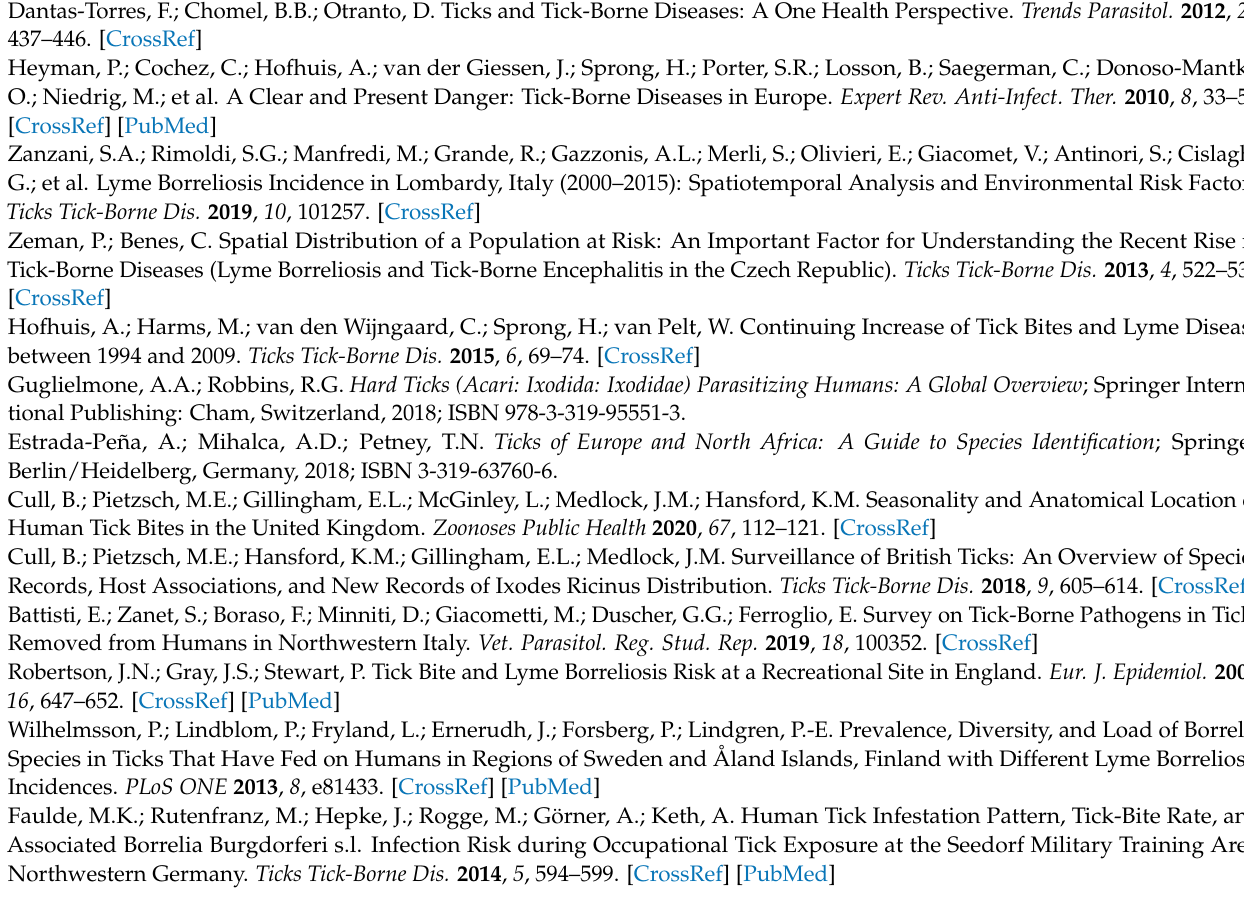
Figure A2. Minimum proportion of orienteers using repellent per racing round. The number represents the number of orienteers participating in the competition.